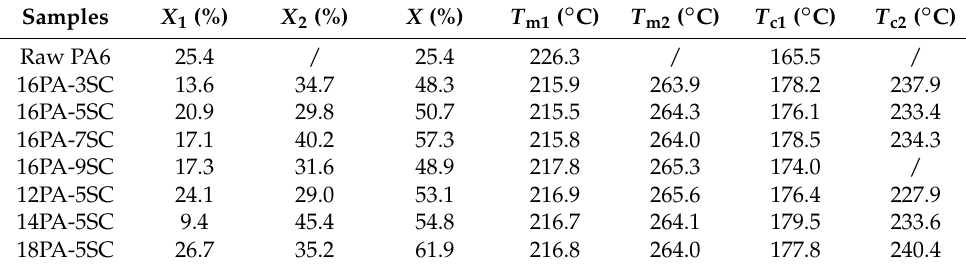
Table 1. Crystalline melting temperature and crystallinity of PA foams.